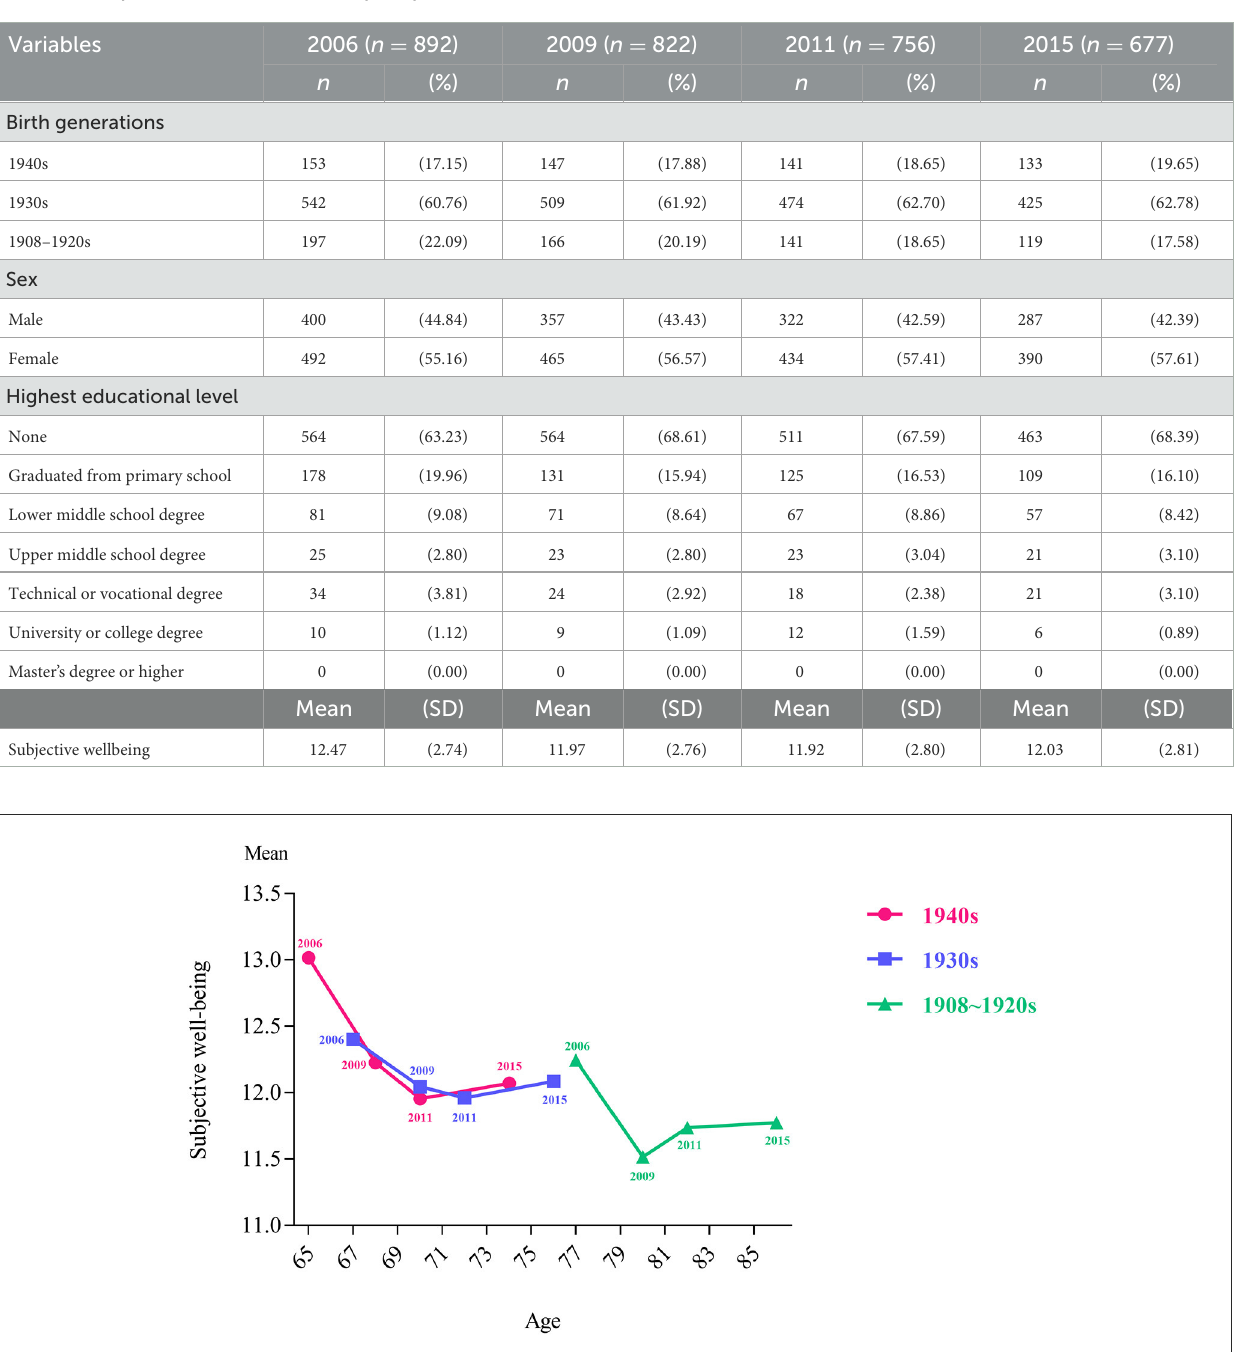
preference for walking or Tai Chi and a higher subjective wellbeing ( β = 0.395, p < 0.05). Model 2 discovered that a preference for eating vegetables ( β = 0.548, p < 0.05), preference for reading ( β = 0.433, p < 0.01), and preference for watching TV ( β = 0.416, p < 0.001) were all significantly positively associated with subjective wellbeing for rural elderly people born in the 1930s. For rural elderly people born in the 1908–1920s, Model 3-1 showed that a greater preference for watching TV was associated with a